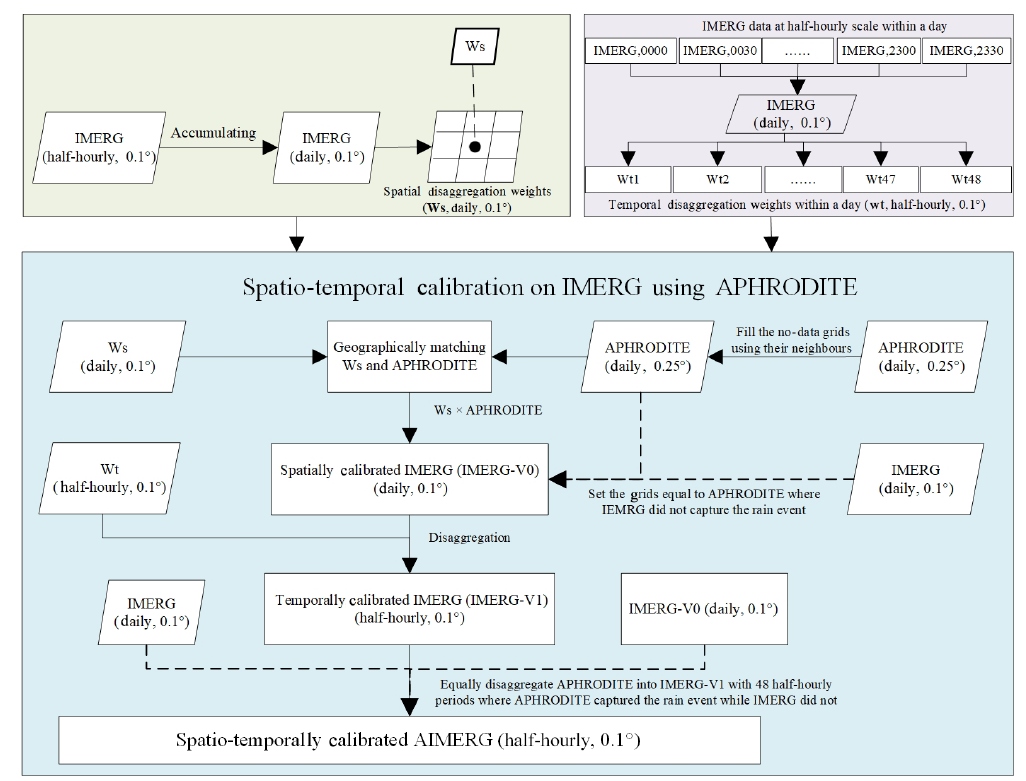
Figure 1. The flowchart of the Daily Spatio-Temporal Disaggregation Calibration Algorithm, DSTDCA, to generate the AIMERG dataset over Asia, 2000–2015.